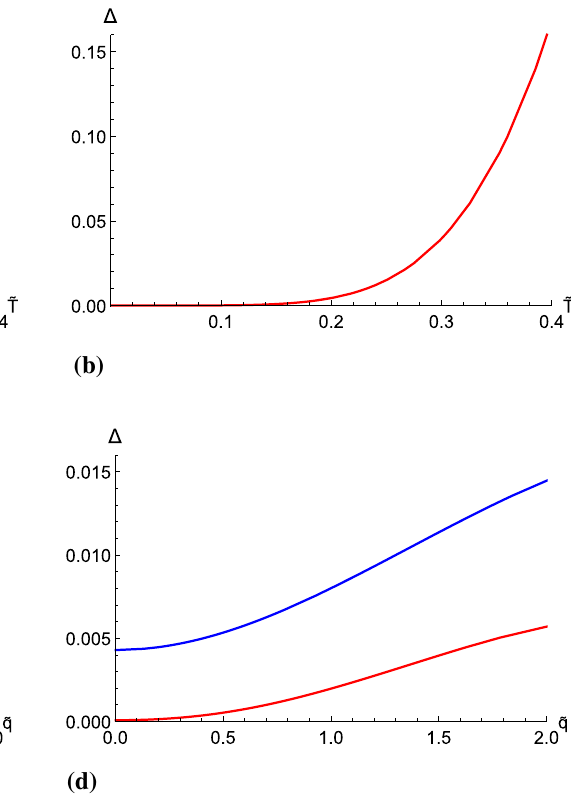
dashed, Green) and ˜ T = 0 . 2(Blue-dashed, Orange). In d , (cid:13) of the case ˜ T = 0 . 2(Blue) is larger than that of the case ˜ T = 0 . 1(Red). When ˜ T has a small value, the analytic result gives a good